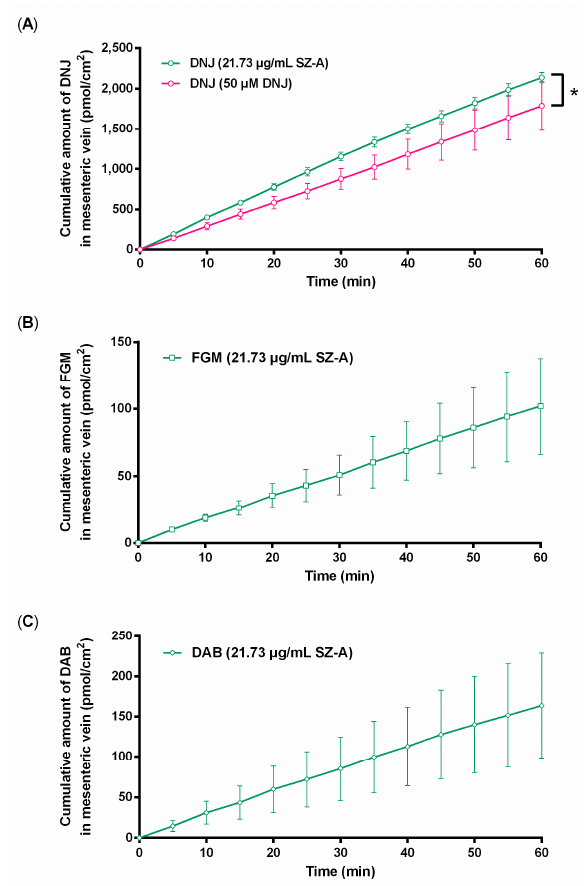
Figure 3. Cumulative amount of DNJ ( A ); FGM ( B ); and DAB ( C ) in the mesenteric vein after rat jejunum perfusion ( n = 5). The statistically significant difference is between SZ–A at 21.73 μ g/mL and DNJ (50 μ M), * p < 0.05.